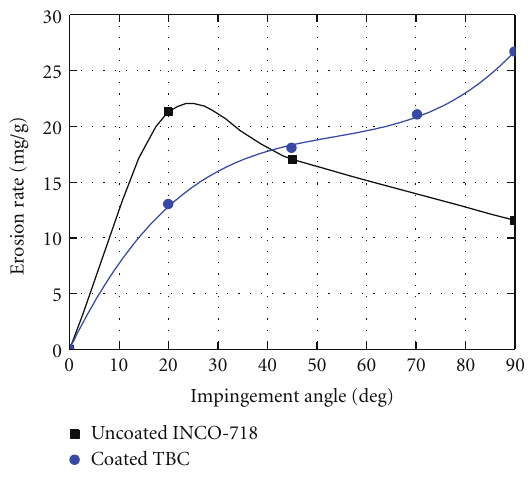
Figure 5: Measured erosion rates due to 26 μ m alumina particles on TBC-coated and uncoated samples ( T = 1093 ◦ C (2000 ◦ F), V = 365.8 m/s (1200 ft/s)).